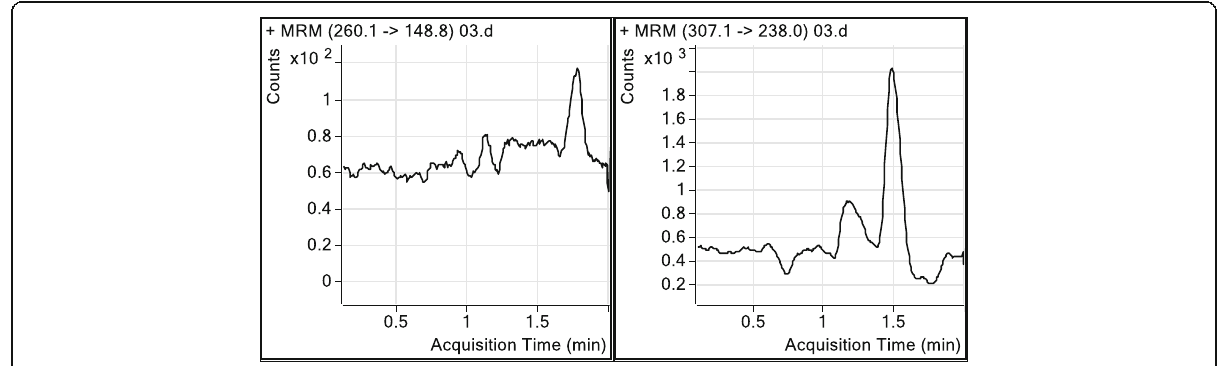
Fig. 1 Representative chromatogram of human blank plasma sample of lenalidomide and IS